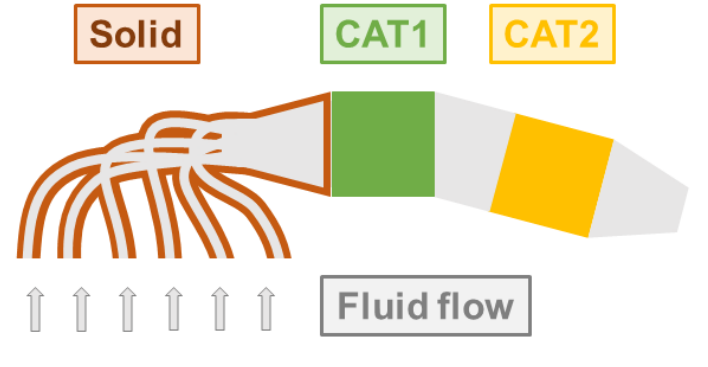
Figure 6. Assessment of the emissions abatement at the cold start: exhaust line